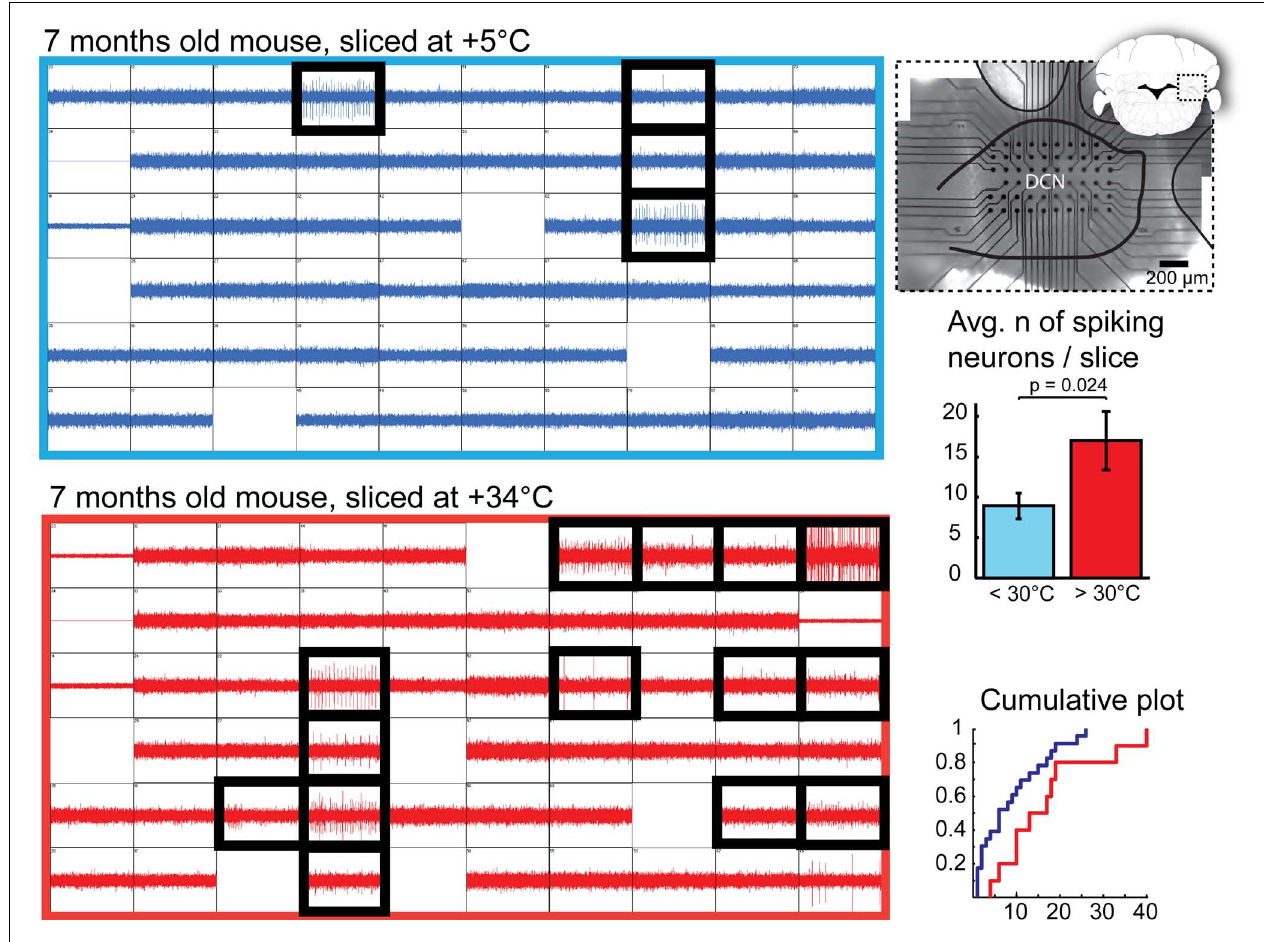
FIGURE 2 | Quantification of DCN slice healthiness with multi-electrode array recordings. Left: representative recordings with 60 planar extracellular electrodes from 7-month old mice from DCN slices prepared at cold (top, blue) and warm (bottom, red) temperatures. Each grid square represents 1 s of continuous recording (vertical axis: 100 pA); blank squares are electrodes with degraded recording quality. Electrodes in which spiking cells were detected are indicated with black, thick squares. A micrograph combined with